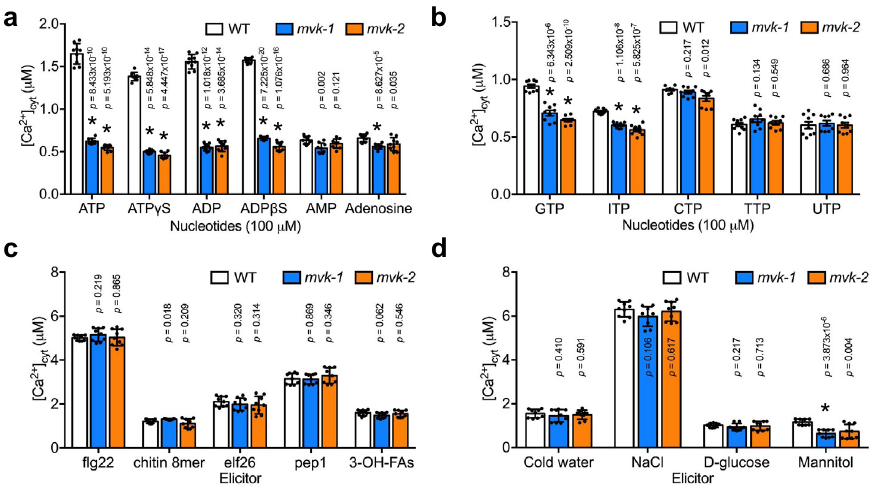
Fig. 4 The mvk mutants show defects in the calcium response to various nucleotides. a Calcium responses to adenine nucleotides and non-hydrolysable derivatives in ColQ, mvk-1 , and mvk-2 ( mvk-2-4 line) plants. b Calcium responses to other nucleotides in ColQ, mvk-1 , and mvk-2 ( mvk-2-4 line) plants. c , d Biotic (100 nM of fl g22, chitin, elf26, and pep1; 5 µ M 3-OH-FAs) and abiotic stress reagents (ice-chilled water, 300 mM NaCl, 5% D-glucose, and 300 mM mannitol) induced calcium responses in mvk mutants. Asterisks indicate signi fi cant differences between ColQ and mvk mutants plants. All data represented as means ± SEM, n = 9 seedlings (* P < 0.001, two-sided Student t test). All above experiments were repeated three times with similar